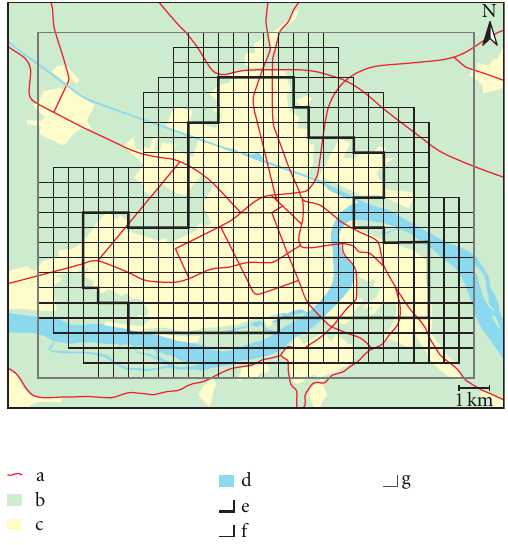
Figure 4: Grid network of the study area with its 1.5 km wide exten- sion in Novi Sad: (a) main roads, (b) rural areas, (c) urban areas, (d) water bodies, (e) border of the study area, (f) cell border in the study area and in its extension, and (g) border of the rectangle containing the grid network.